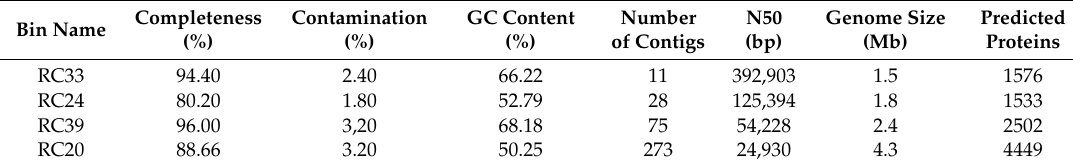
Table 3. Details of genomic bins obtained.